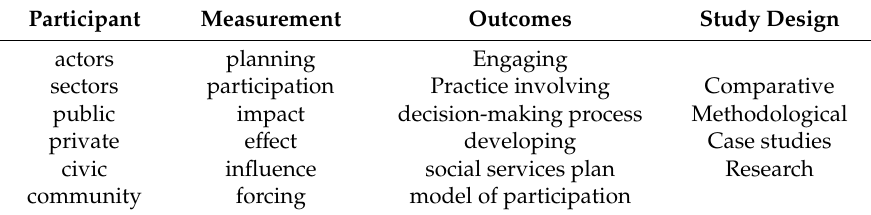
Table 13. Key words for identifying key literature of current